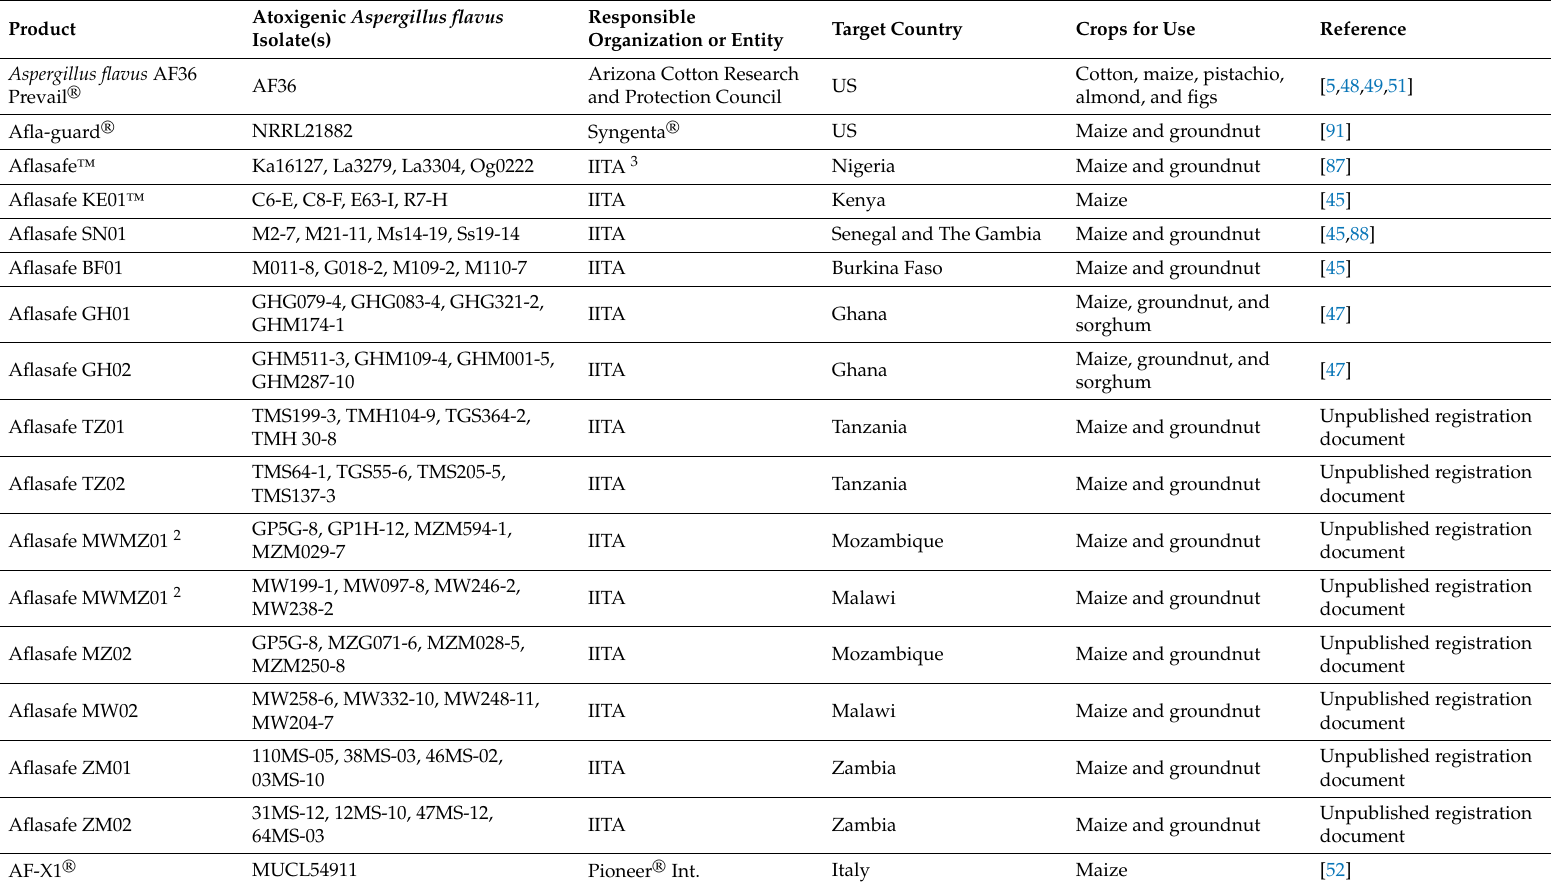
Table 2. List of aflatoxin biocontrol products registered for commercial use 1